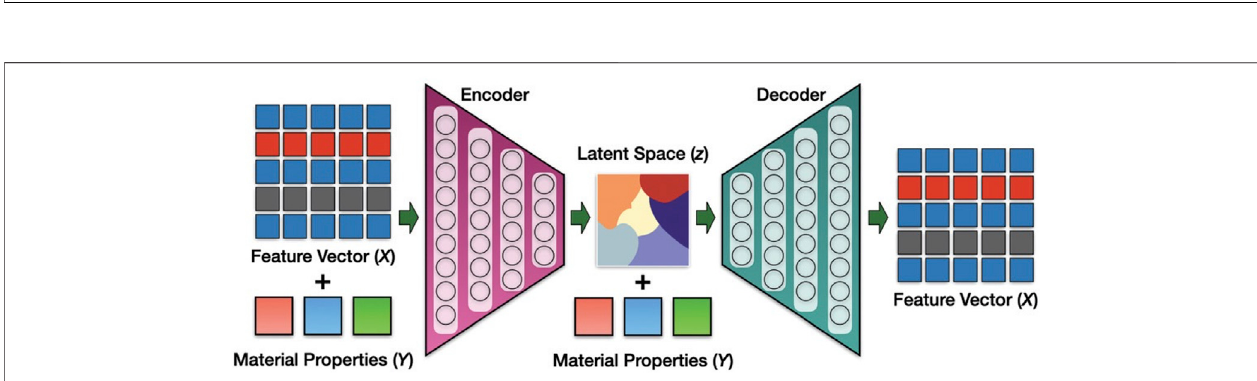
FIGURE7| DINGarchitecture.CVAEisused togenerate materialswithspeci fi cproperties(formationenthalpy,energyper atom,andvolumeper atom).Reprinted with permission from Pathak et al. (2020).